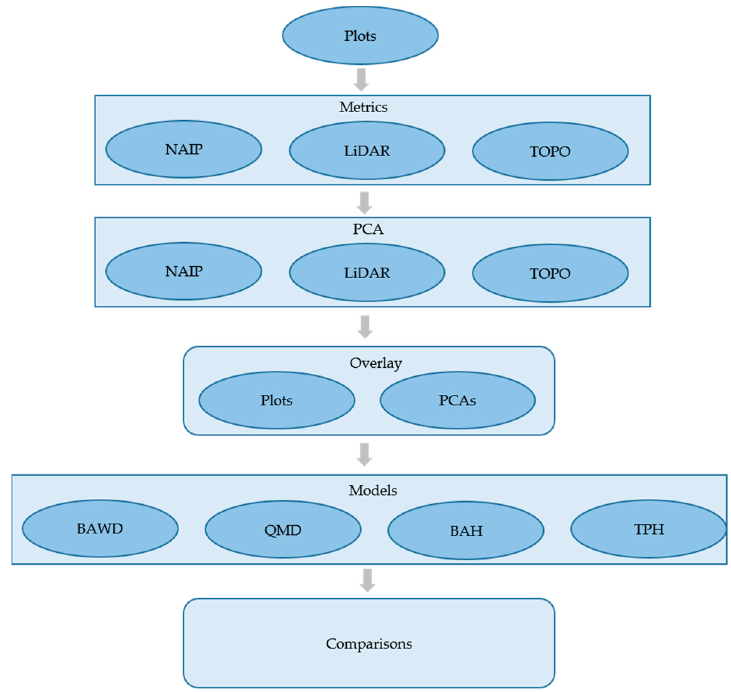
Figure 3. Flow diagram of the data sources, processing steps, modeling, and comparisons made within the study. NAIP, LiDAR, and TOPO data were converted to texture, height, and elevation metrics and transformed to spatial surfaces using principal component analysis (PCA). PCA surface values were then related to field data based on plot locations (Overlay) and were used to model basal area weighted diameter (BAWD), quadratic mean diameter (QMD), basal area per hectare (BAH) and trees per hectare (TPH) relationships. Modeled relationships were then used to create raster surfaces that were compared at the spatial resolution of the plot and stand.